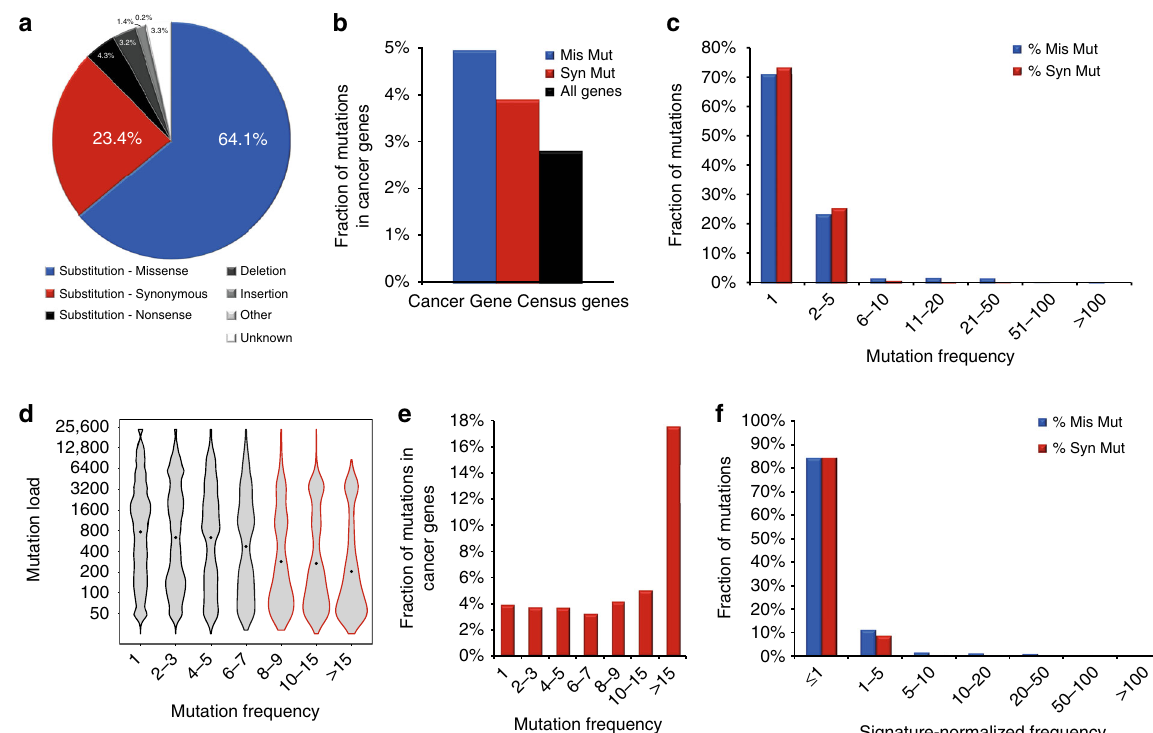
Fig. 1 Properties of synonymous mutations in cancer. a Synonymous mutations are the second most frequent class of point mutations in cancer. b Synonymous mutations (Syn Mut) and missense mutations (Mis Mut) are enriched in cancer-associated genes compared with the proportion of annotated cancer genes among all human coding genes (All Genes). c Synonymous mutations (Syn Mut) display a similar recurrence pattern as missense mutations (Mis Mut) with more than 25% of mutations found recurrently in more than one sample. d The violin plot depicts the distribution of the mutation loads of the samples associated with different frequencies of the synonymous mutations with the median indicated by a dot. e The fraction of synonymous mutations in known cancer-associated genes increases for highly recurrent synonymous mutations. f The frequency of synonymous mutations (Syn Mut) and missense mutations (Mis Mut) are normalized to a mutation signature to account for the mutation bias in cancer